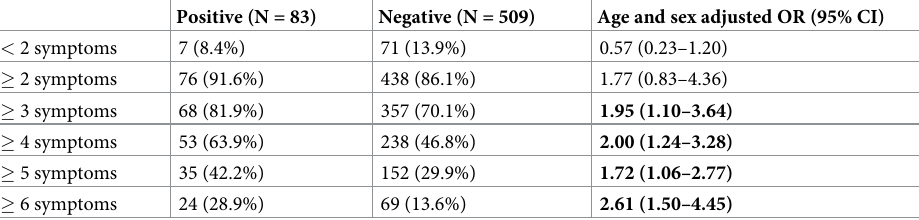
Table 3. SARS-CoV-2 test results by number of symptoms reported at triage a .